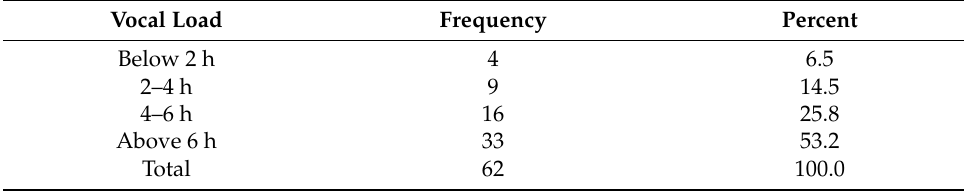
Table A1. Vocal load (missing data: n =